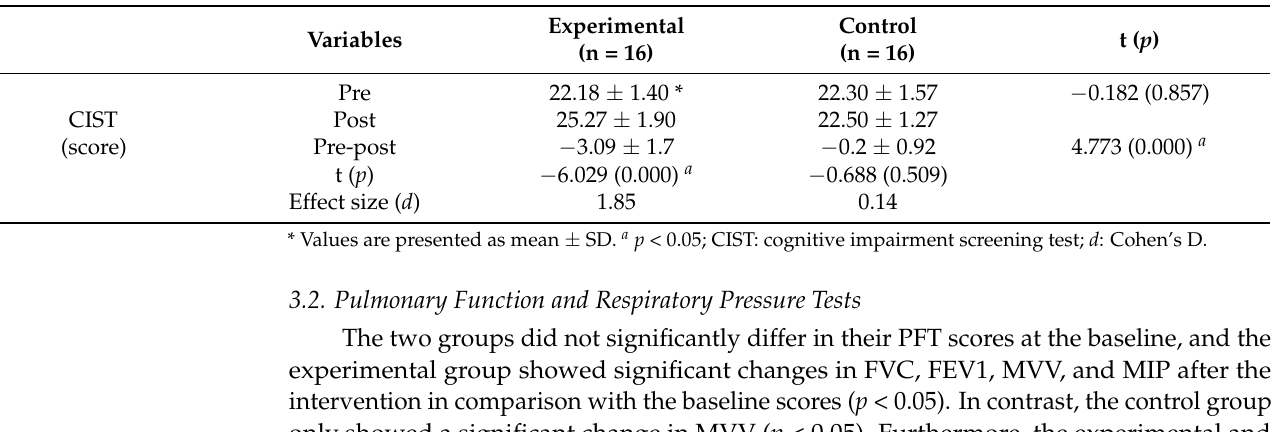
Table 4. Comparison of CIST score within and between groups.